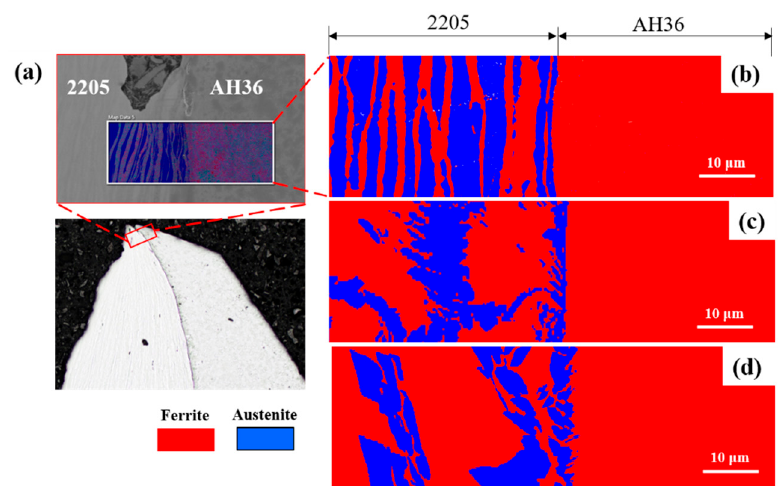
Figure 7. ( a ) The observed zone after tests, and the phase maps: ( b ) as received, ( c ) at 950 °C–0.01 s –1 and ( d ) at 1250 °C–0.01 s –1 .